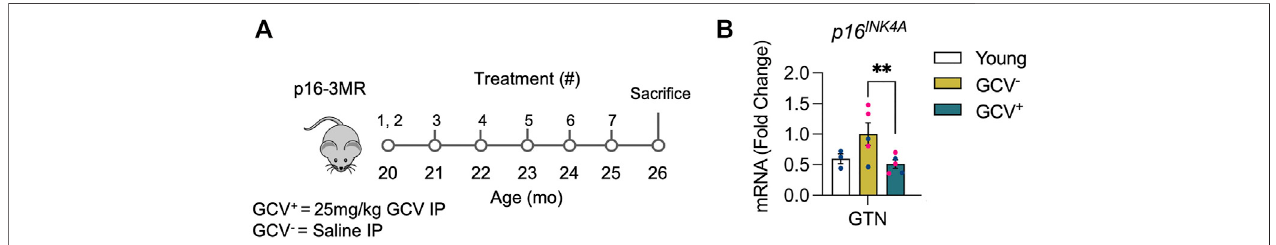
FIGURE 1 | GCV + muscle showed reduced expression of p16 INK4A . (A) p16-3MR mice were given ganciclovir (GCV + ) or vehicle (GCV − ) via intraperitoneal (IP) injection at 20-month of age for 10 days over 2 weeks. Additional 5-day treatments were administered over 1 week in fi ve subsequent months until sacri fi ce